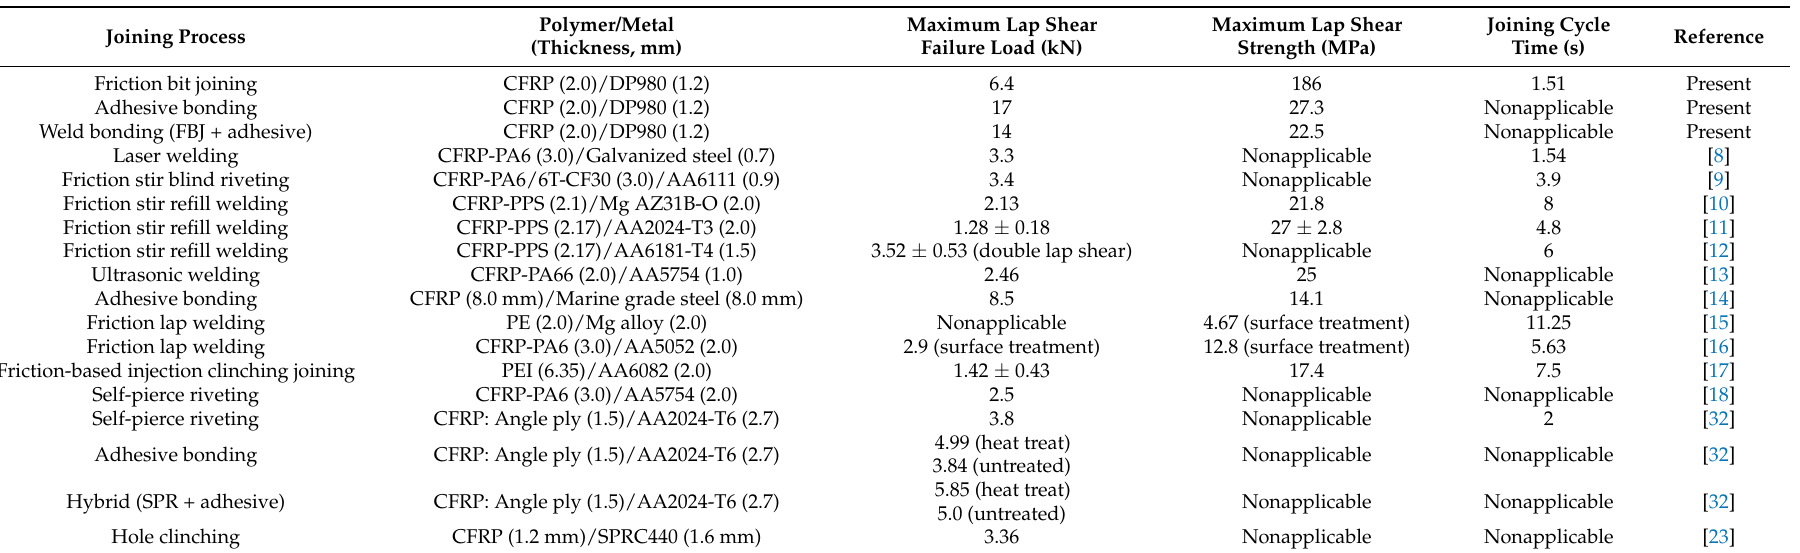
Table 5. Summary of state of the art for joining polymers to